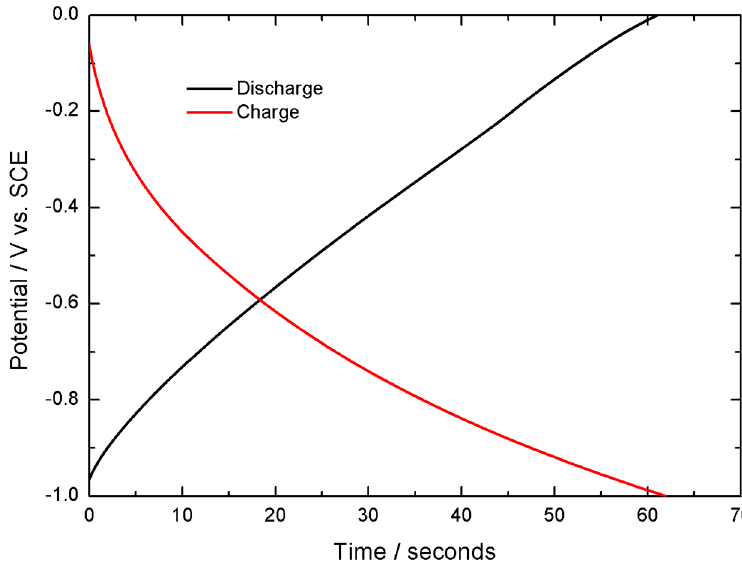
Figure 8. Galvanostatic charge and discharge curves obtained at 10 mA cm − 2 for the negative electrode, YEC-8A.